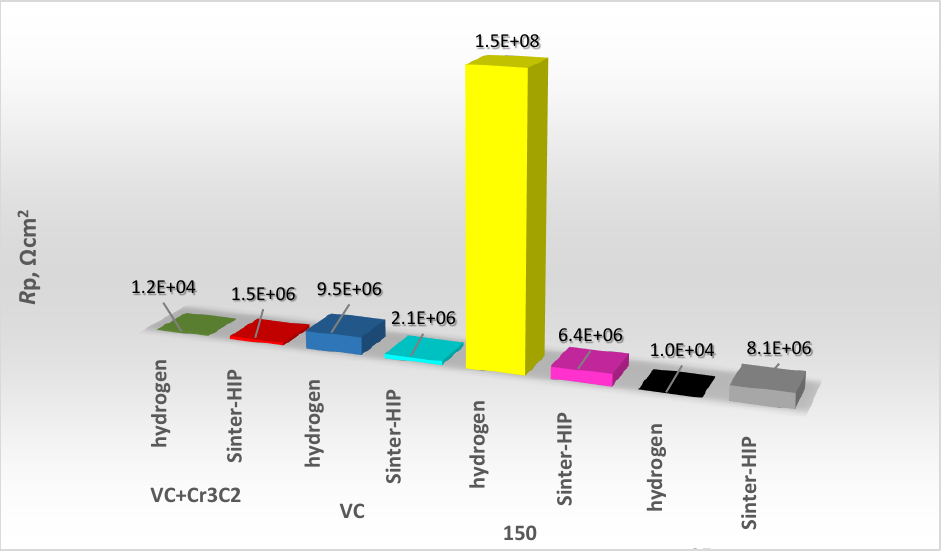
Figure 7. Graphical presentation of polarisation resistance.